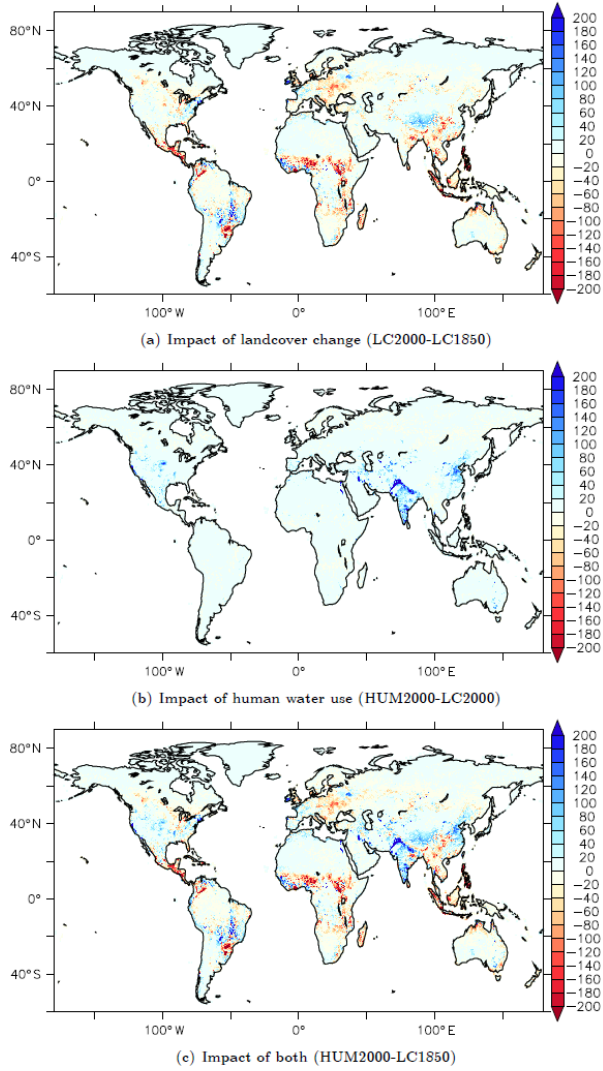
Figure 5. Difference in annual average discharge between the ex- periments, averaged over 1979–2010 (in m 3 s − 1 ). Higher discharge for HUM2000 occurs over reservoirs, which are not included in LC1850 or LC2000.